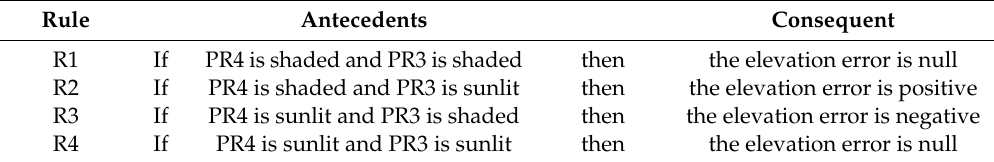
Table 2. Action rules for the elevation error (PR4 and PR3).